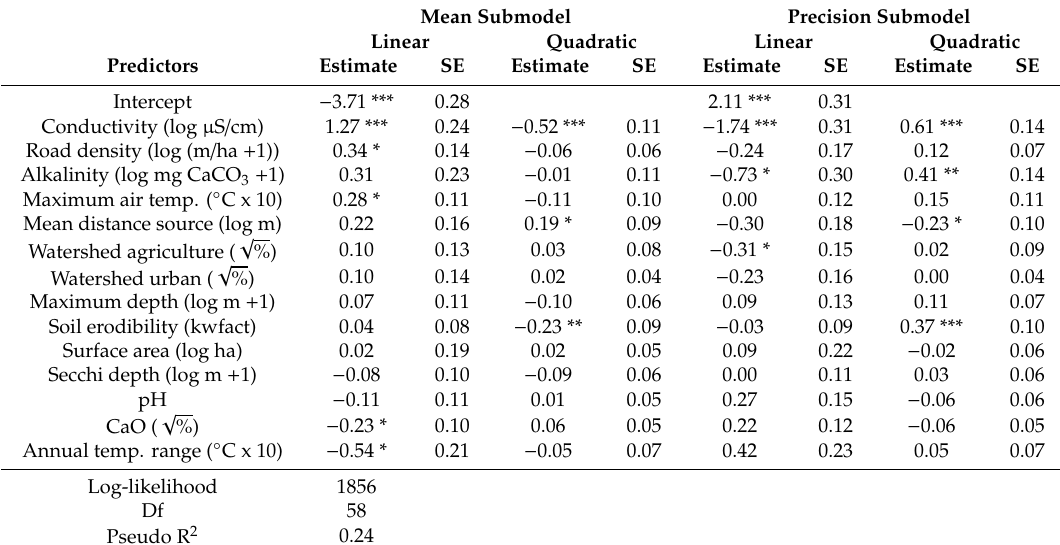
Table 3. Coe ffi cients estimated using a beta regression model for abundance data on 657